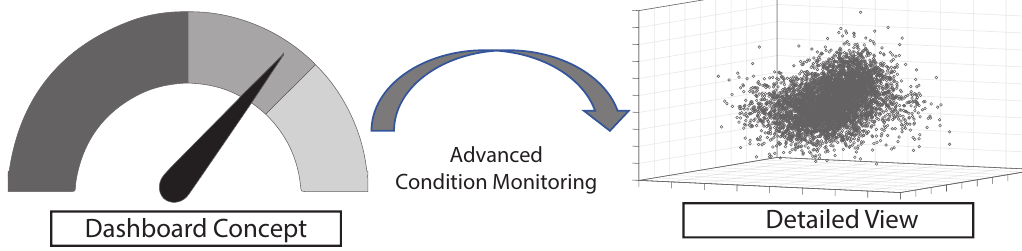
Figure 1. The basic idea of this work is to provide visual, algorithm supported insights into large datasets. As a result, these datasets can be visually inspected to enhance or replace current dashboards